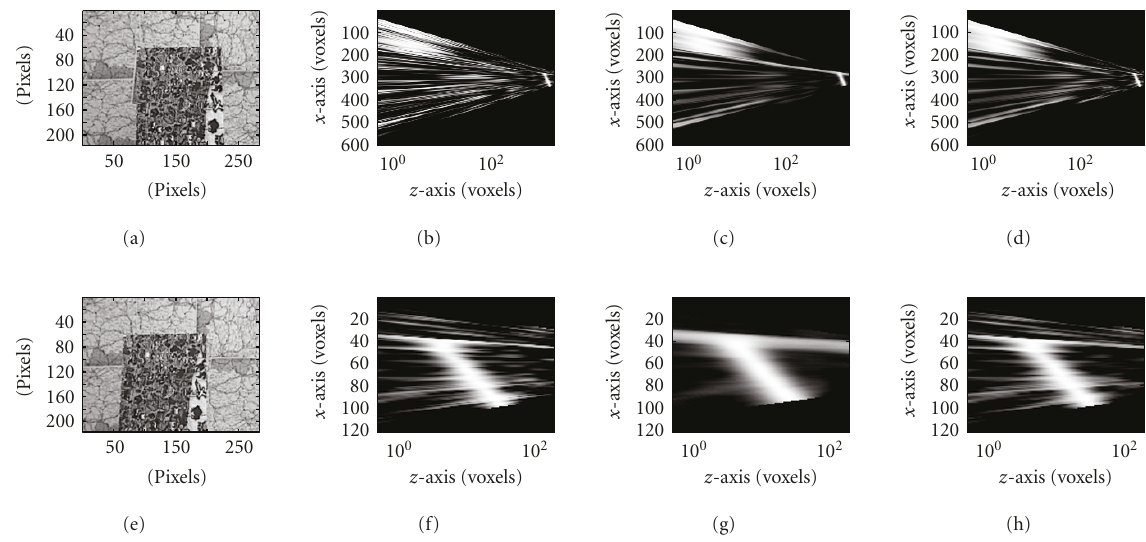
Figure 5: Shown is “Map” middlebury stereo pair (left column) and three separate calculations of s across a vertical section, through the middle of the foreground surface. The bottom figures are zoom-in details on the part that corresponds to the foreground surface in the image pair. The z -axes (horizontal in maps) are logarithmic. In the bottom figures, ground truth is marked with a dashed line. Columns 2 and 3 (from the left) correspond to the small and large α , respectively. The right column shows the response of for the size-modulated α .